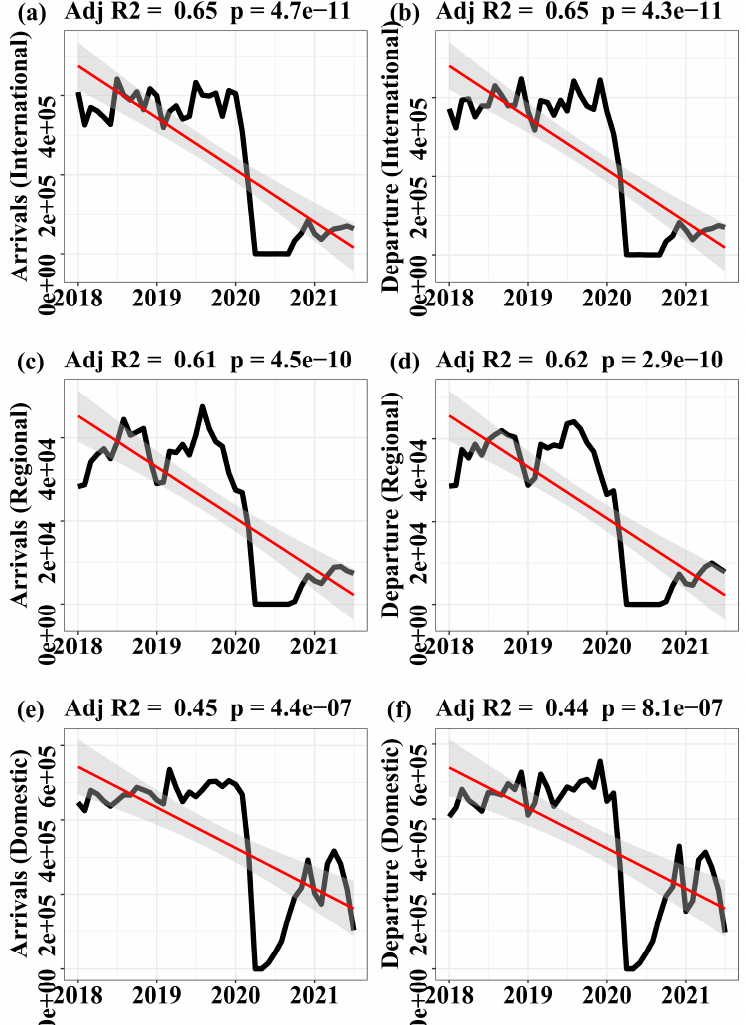
. Figure 1. The linear trend analysis of international, regional, and domestic aircraft movements from 2018 to 2021 at OR Tambo International Airport (FAOR). ( a , b ) show trends in international arrivals and departures, respectively, ( c , d ) show trends in regional arrivals and departures, respectively, while ( e , f ) show trends in domestic arrivals and departures, respectively. Table 3. Pettitt’s test for single change-point detection from arriving and departing flights at OR Tambo International Airport (FAOR) and Cape Town International Airport (FACT), respectively.